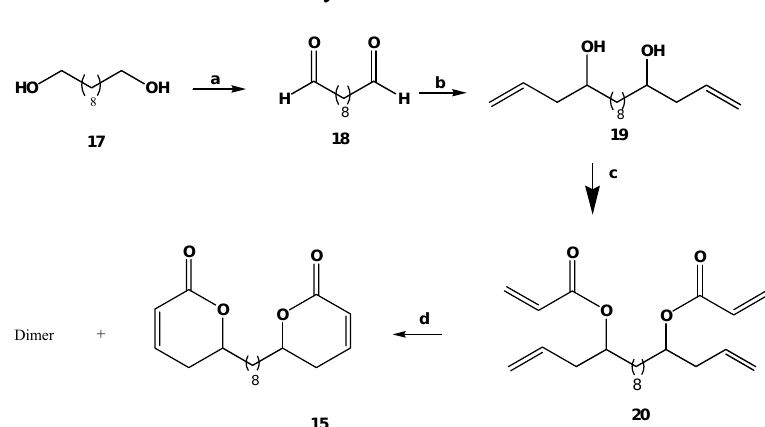
Scheme 2. Synthesis of dilactone 15